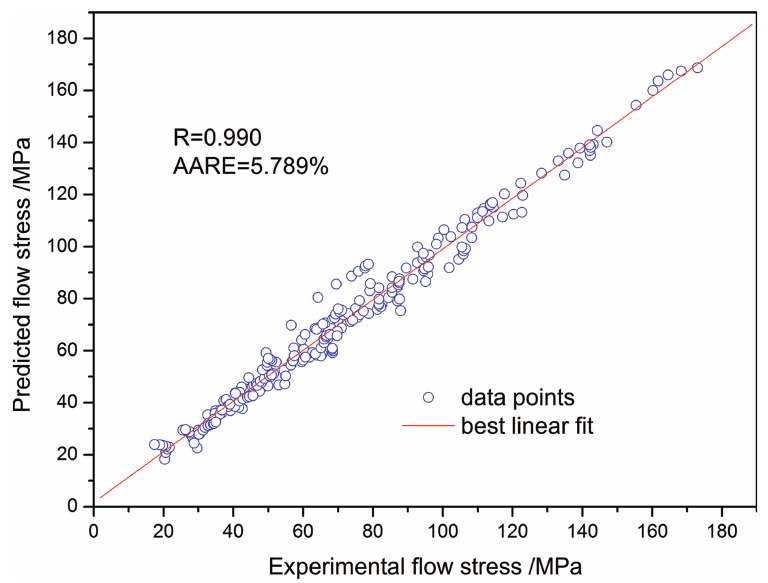
Figure 14: Correlation between the experimental and predicted flow stress data from the developed constitutive equation.